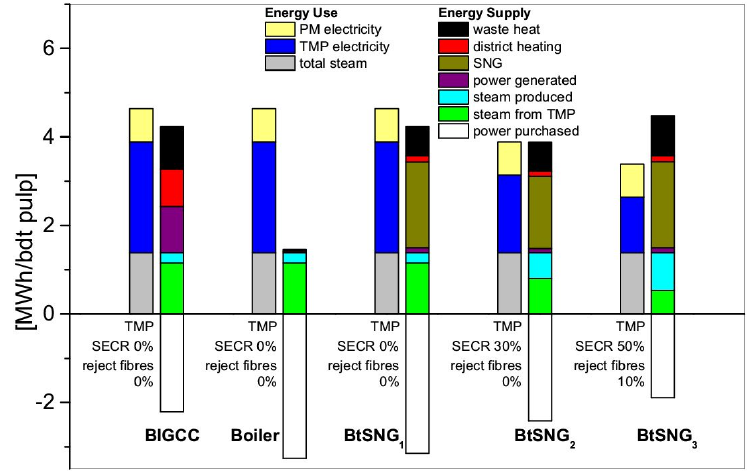
Figure 5. Energy balance when SNG or electricity is produced in a TMP mill [23].